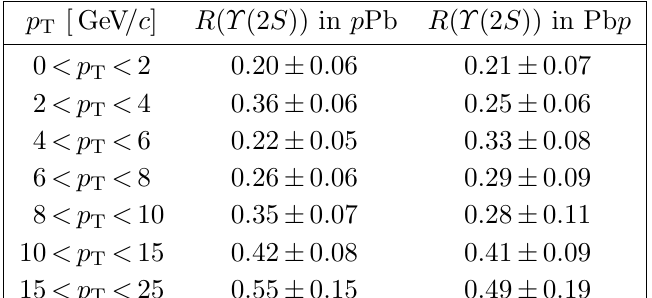
Tables 18 and 19 list the (cid:7) (2 S ) to (cid:7) (1 S ) ratios in bins of transverse momentum bins and rapidity. In all tables, the quoted uncertainties are the sum in quadrature of the statistical and systematic components.